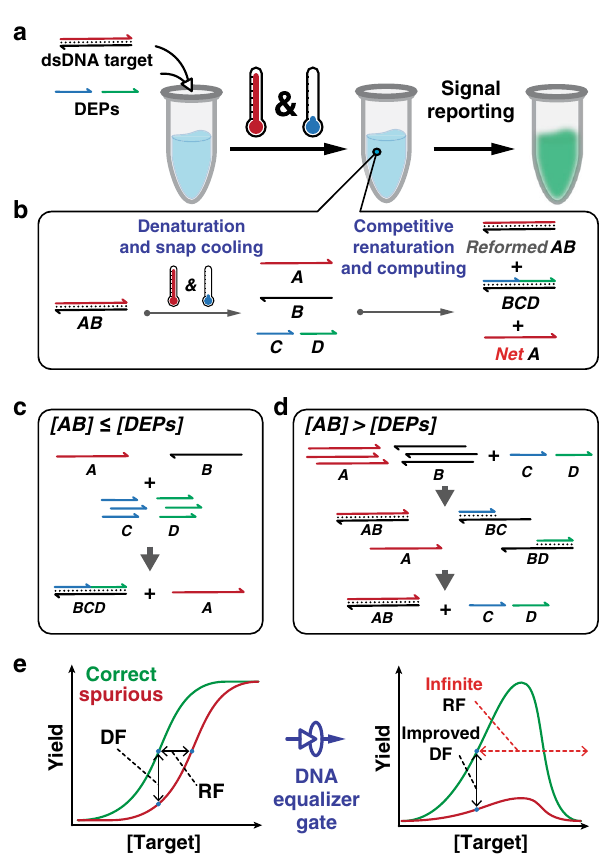
Fig. 2 Schematic illustration of the DNA Equalizer Gate (DEG). a The overall work fl ow for quantifying dsDNA using DEG. A mixture of target dsDNA and DNA Equalizer Probes (DEPs) is heated and rapidly cooled to produce ssDNA outputs with well-controlled quantity using an autonomous molecular computation in the test tube. Fluorescence signals are then generated via a reporter probe. b Mechanistically, the dsDNA target (AB) is denatured into A and B during a heating and snap cooling procedure. A competition between DEPs (C and D) and A then occurs for hybridizing with B during renaturation. The net amount of the ssDNA output (A) is quantitatively determined by an autonomous computing process that compares the initial concentrations between the target and DEPs. c When [AB] ≤ [DEPs], the reaction between B and DEPs (i.e. the formation of BCD) is thermodynamically favored, which maximizes the production of A. d When [AB]> [DEPs], BC and BD are generated as intermediates, which then consumes A through strand displacement. e Through this computing process, DEG transforms the quantitative relationship between the detection signal and target concentrations from a typical sigmoidal function to a unimodal function. As such, detection signals for a spurious target is signi fi cantly suppressed, enabling a much-enlarged detection window and improved discrimination factor